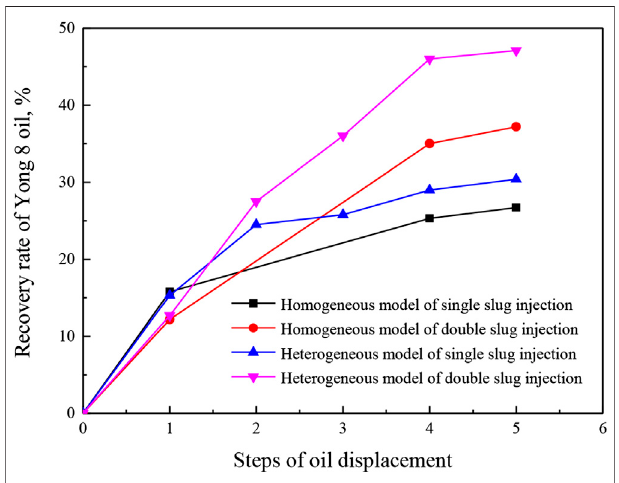
FIGURE 9 | Improvement in Yong eight oil recovery using the OH-3 oil- displacing agent